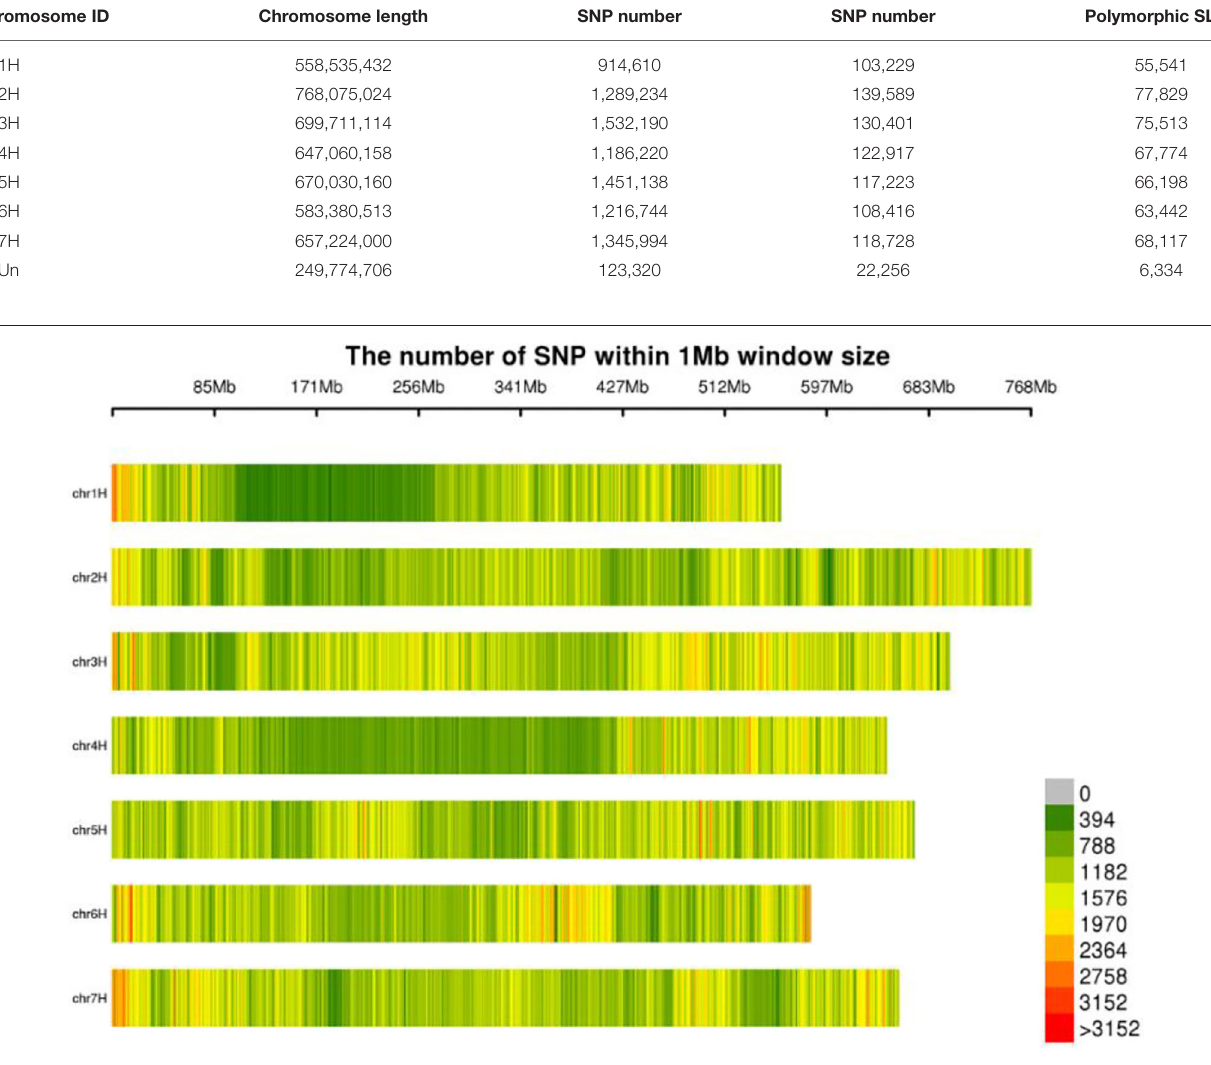
FIGURE 1 | Distribution of SNPs on